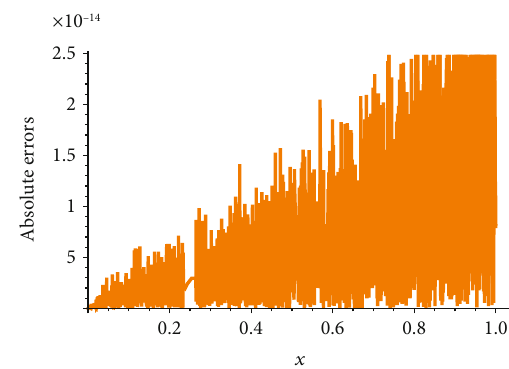
Figure 11: Absolute errors of u with α = β = 1/2 for Example 2.